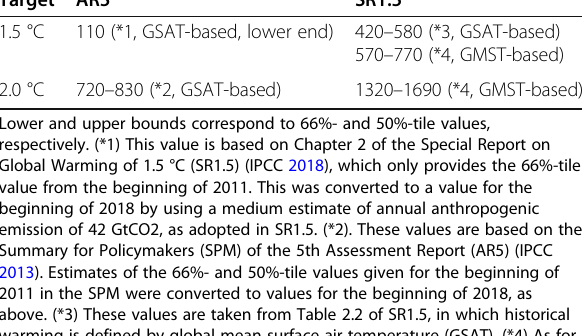
Table 1 Estimates of the remaining carbon budgets for early 2018 for different mitigation targets. Units: GtCO 2 Target AR5